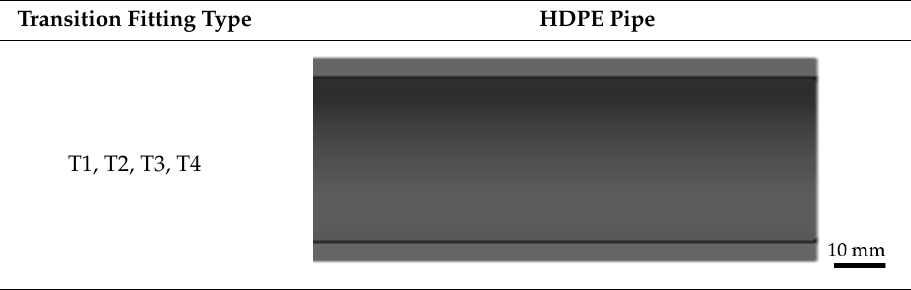
Table 8. Constructive shape of HDPE pipe.